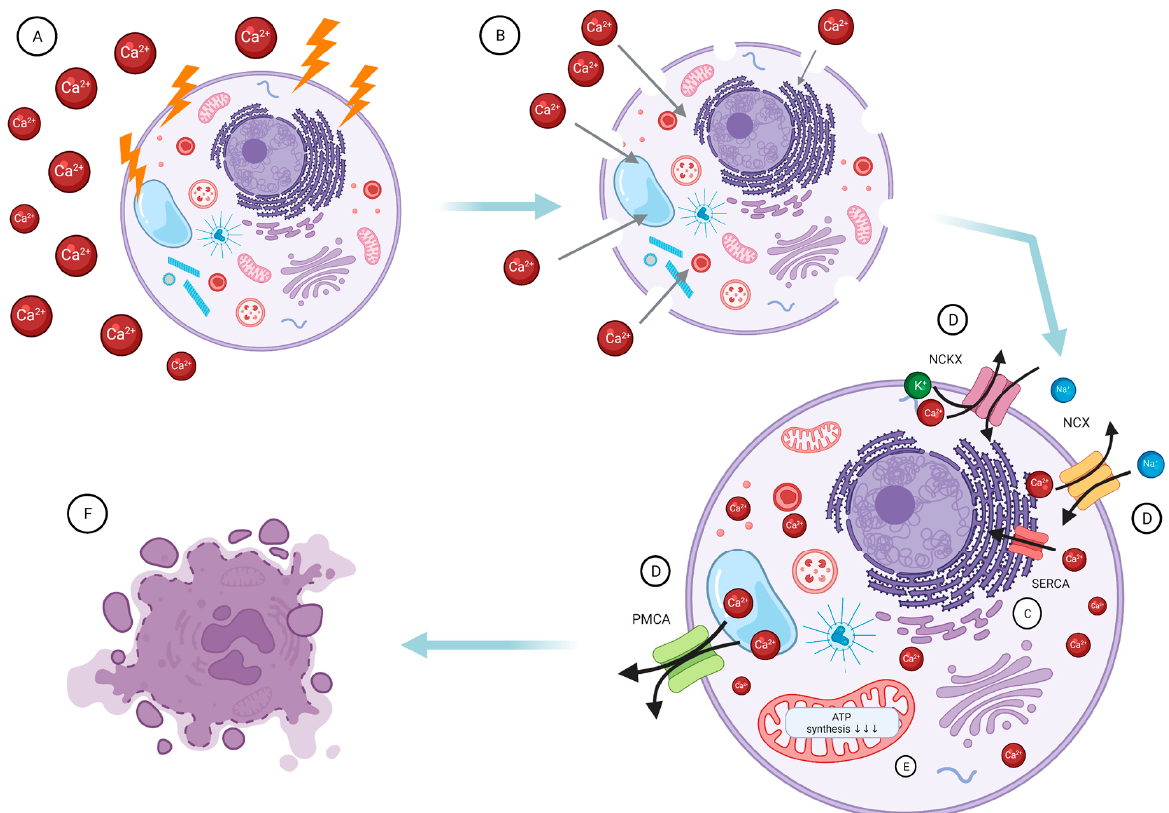
Figure 3. The general mechanism of calcium electroporation (CaEP). The concentration of calcium on both sides of the cell membrane (CM) is tightly controlled. The CaEP mechanism of action involves ( A ) application of Ca 2+ supraphysiological concentration. ( B ) Subsequent application of electrical pulses which increases the permeability of the CM, which allows calcium introduction into the interior of the cell. ( C ) Ca 2+ transportation to the mitochondria and the endoplasmic reticulum by sarco- endoplasmic reticulum calcium ATPase (SERCA). ( D ) Disruption of calcium homeostasis triggers the enhanced activity of the sodium-calcium potassium exchanger (NCKX), the sodium-calcium exchanger (NCX), and ATP-dependent plasma membrane calcium ATPase (PMCA) to extrude the extra Ca 2+ from the cell. ( E ) At the same time, an increase in the Ca 2+ concentration inhibits the process of ATP synthesis, leading ultimately to the complete use of its resources and cell death ( F )